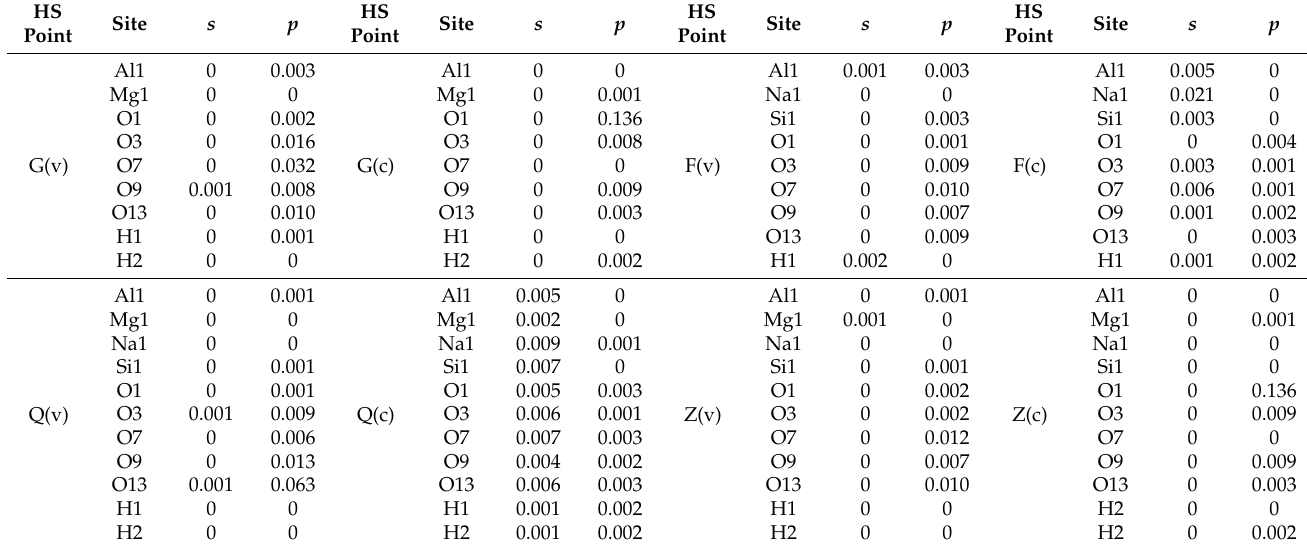
Figure 3. The total density of states ( a ) and partial density of states ( b – l ) of the Na-MMT and Mg-MMT at 0 GPa. Table 3. Calculated orbital-decomposed site (atom)-projected electron charges inside the muffin-tin spheres of the Na-MMT at the high-symmetry (HS) BZ points G, F, Q, and